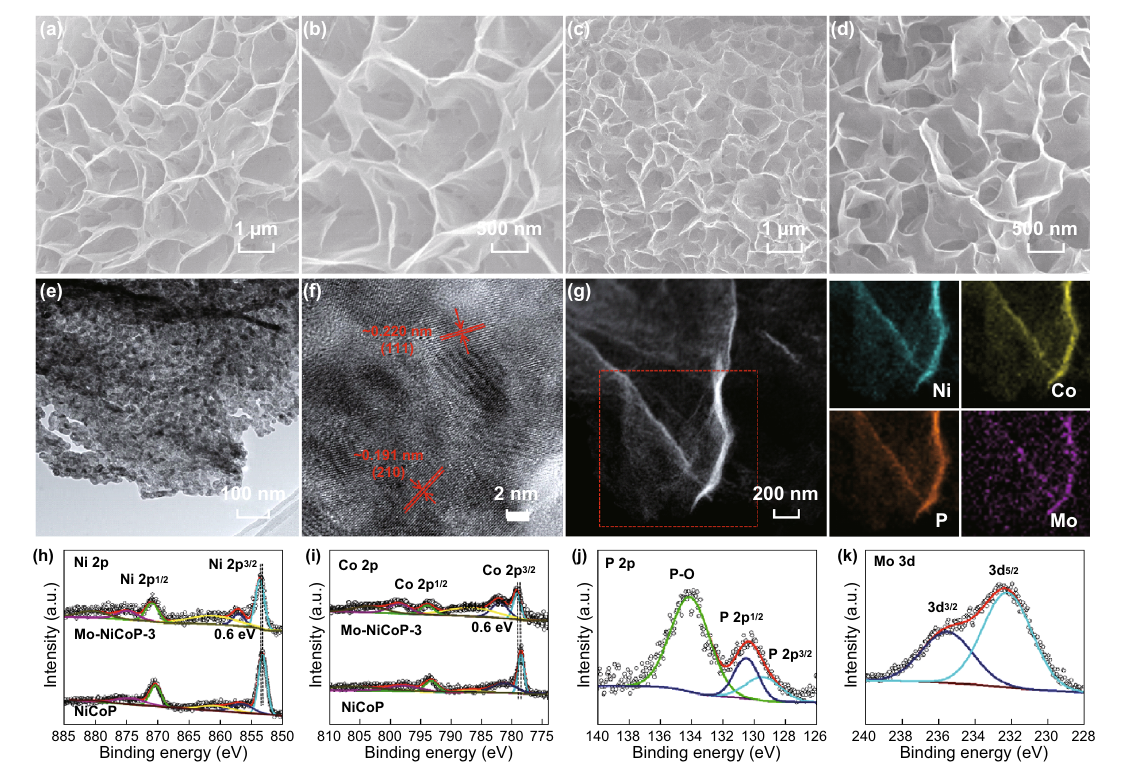
Fig. 1 SEM images of a , b NiCoP and c , d Mo–NiCoP-3. e TEM, f HRTEM, and g the corresponding element mapping in Mo–NiCoP-3. XPS h Ni 2 p and i Co 2 p spectra in NiCoP and Mo–NiCoP-3. XPS j P 2 p and k Mo 3 d spectra in